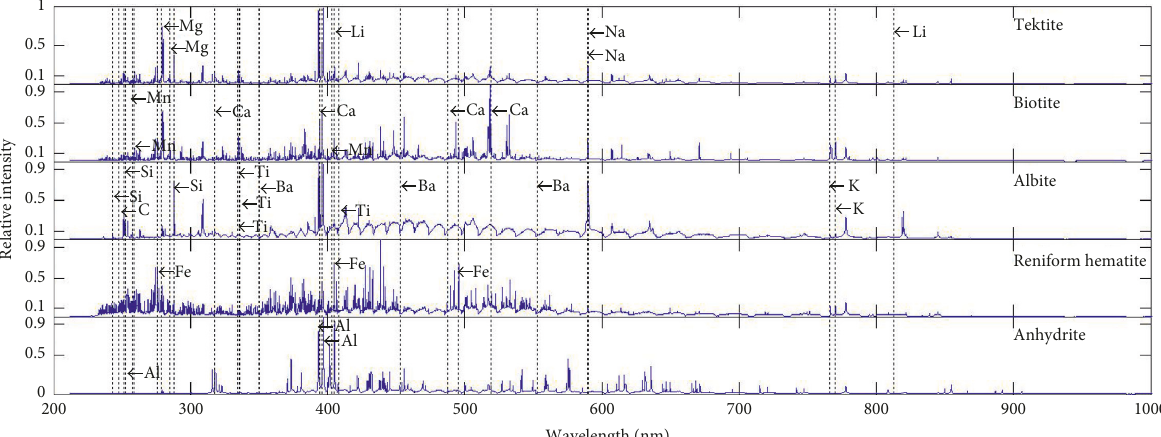
Figure 3: Typical spectral lines of five mineral samples: tektite, biotite, albite, reniform hematite, and